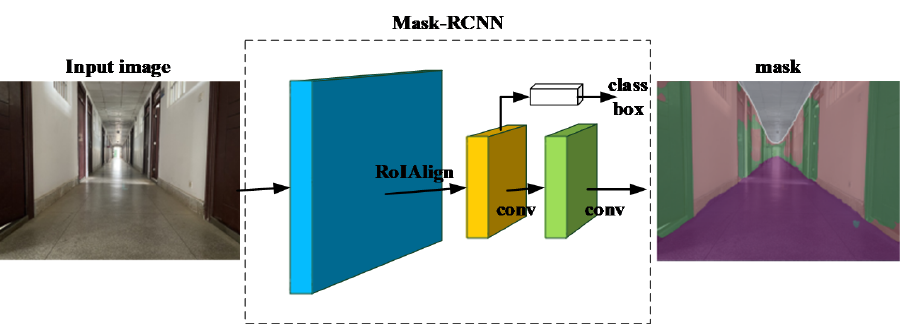
Figure 9. Example of semantic segmentation.